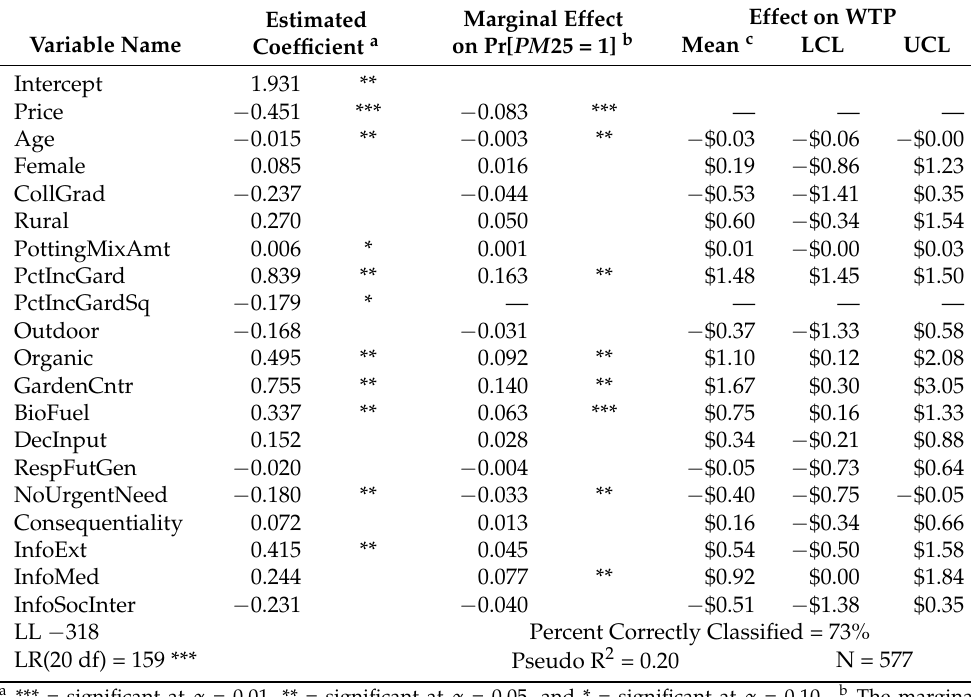
Table 2. Estimated logit model of willingness to pay for 25% biochar potting mix a